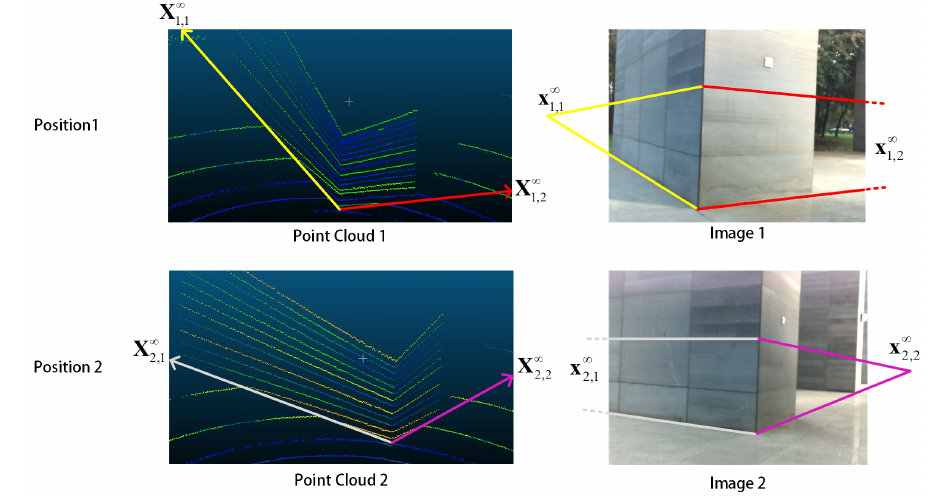
Figure 1. General constraints of our method. The first row shows the point cloud (top-left) and image (top-right) captured at position 1, and the second row shows the case of position 2. X ∞ represents the j , i 3D infinity points in the LiDAR coordinate system. x ∞ represents the corresponding 2D infinity points j , i on the image plane. During the position change, the relative transformation of the two coordinate systems is fixed. In our method, an initial solution can be obtained from at least two